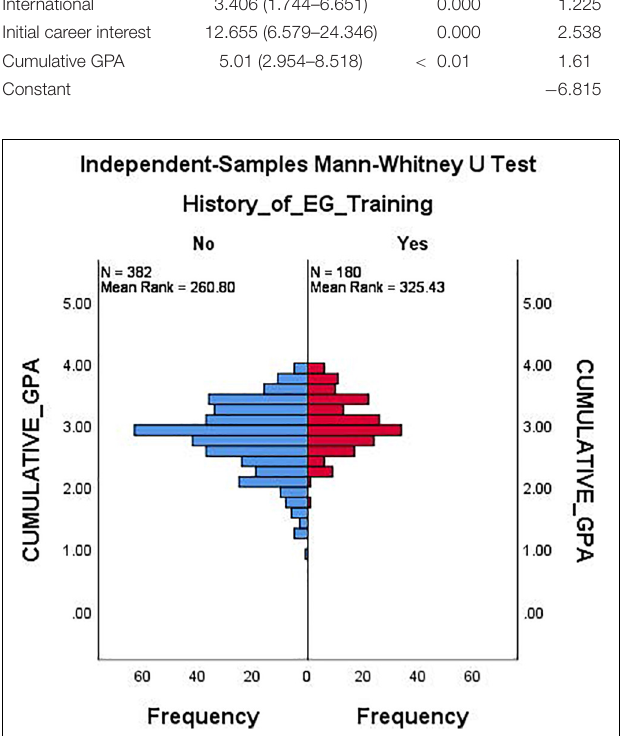
FIGURE 4 | Empower Generations training and cumulative university ’ s